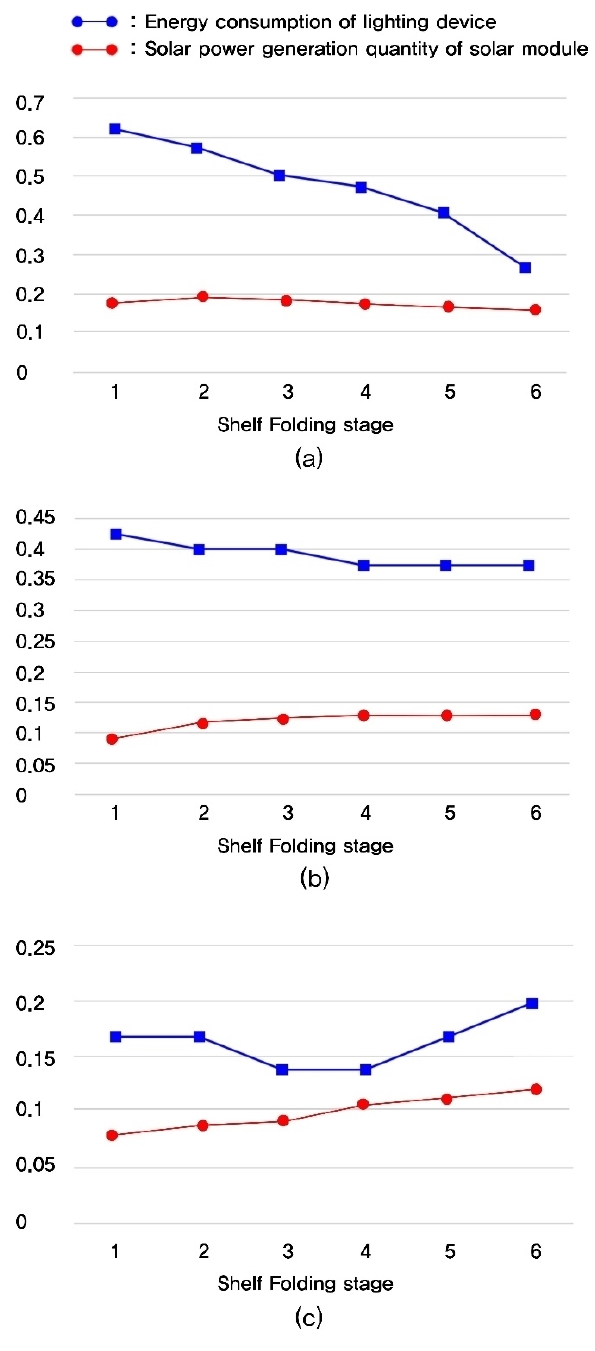
Figure 12. Lighting energy consumption and the power generated by the photovoltaic module according to the folding stage in Case 3: ( a ) Summer, ( b ) Mid-season, ( c ) Winter.